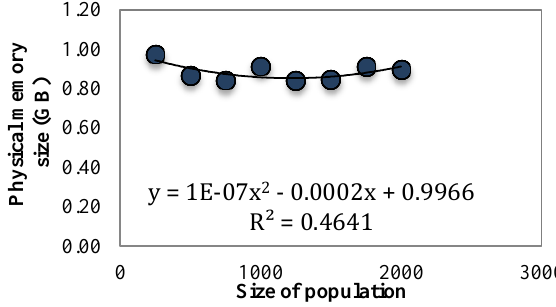
Figure 13. Relationship between the size of population and average physical memory size (GB).